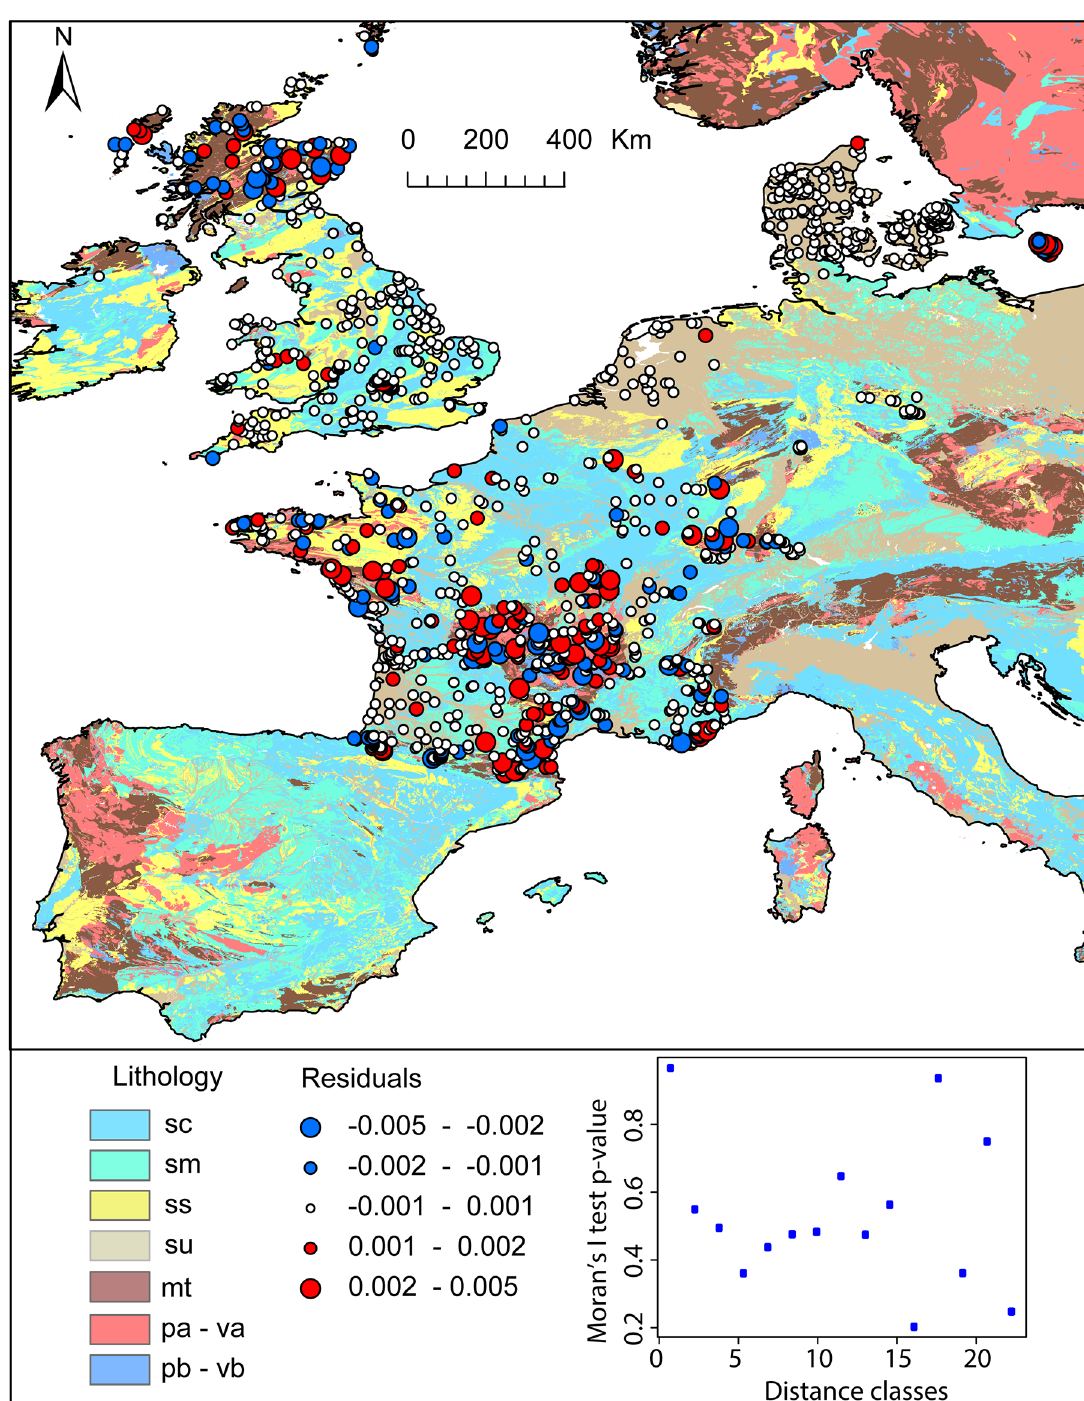
Fig 8. Bubble map of 87 Sr/ 86 Sr residuals for the training dataset plotted over the lithological map of Western Europe from the GLiM database. In the bottom-right corner, a plot shows the p-value of the Moran’s I test for different distance class with p-value > 0.05 indicating no spatial autocorrelation. mt = metamorphic rocks; pa = felsic plutonic rocks; va = felsic volcanic rocks; pb = mafic plutonic rocks; vb = mafic volcanic rocks; sm = mixed sediments; sc = carbonate sediments; ss = siliciclastic sediments; su = unconsolidated sediments. Coastline features are from